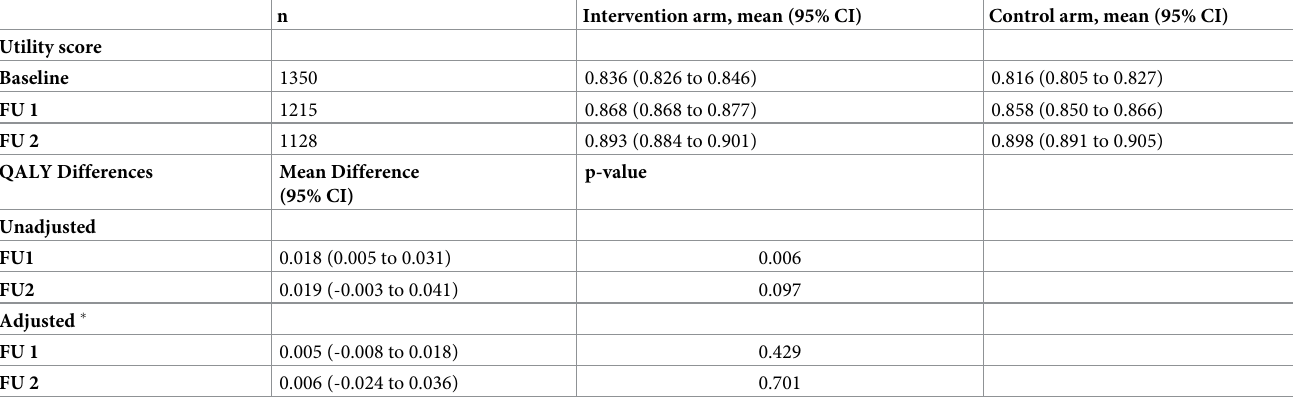
Table 2. Mean utility scores and QALYs per child by treatment